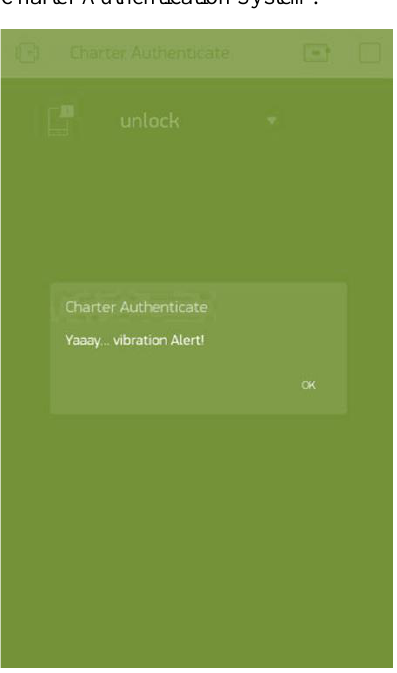
Fig.12. Application showing alert